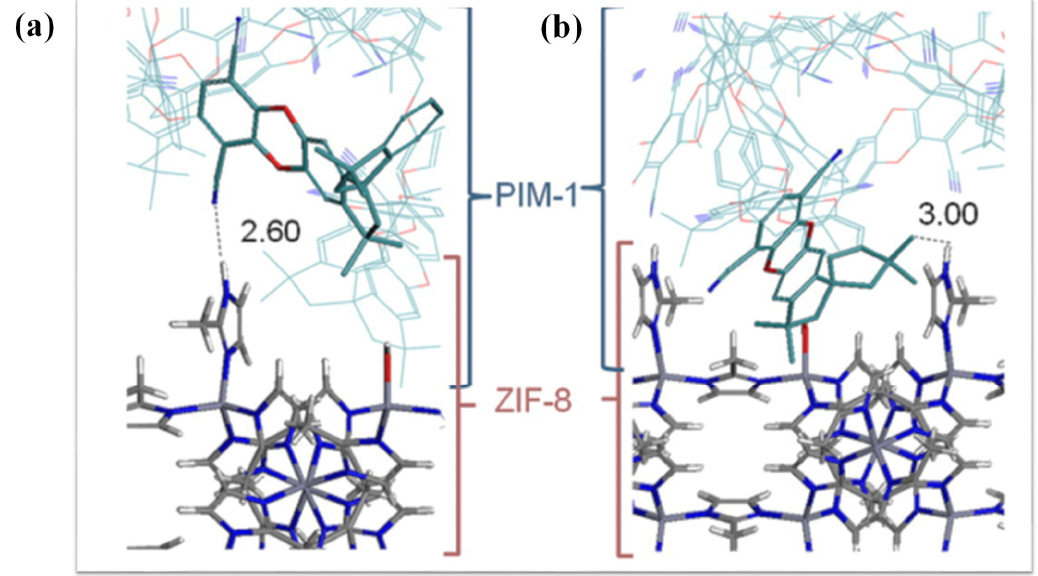
Figure 10. ZIF-8/PIM-1 molecular relation. ( a ) A 2.60 intermolecular interaction bond length and ( b ) a chain reaction 3.00 structural length.